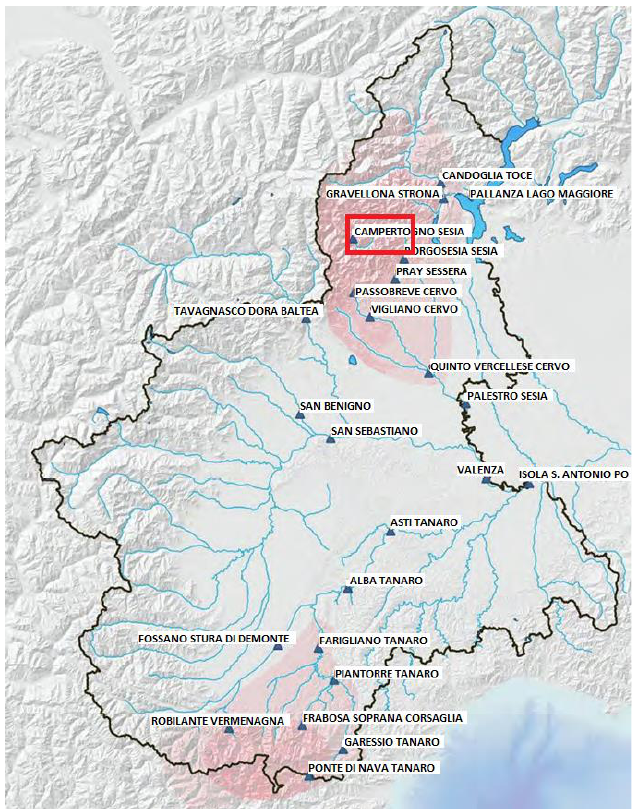
Figure 3. Map of Piemonte region indicating the two areas most involved during the event of 2–3 October 2020 (red coloured). The red rectangle indicates the location of the study area. Adapted with permission from [31]. Copyright 2023, Luino F.